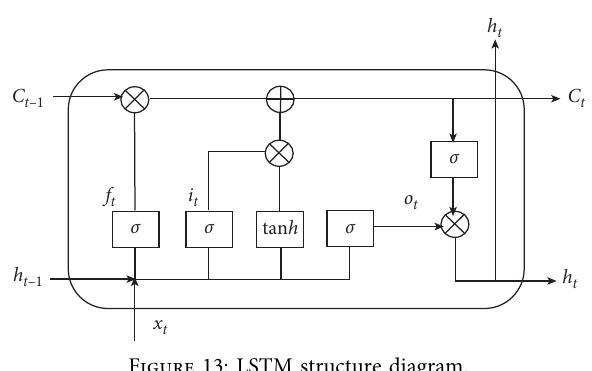
Figure 13: LSTM structure